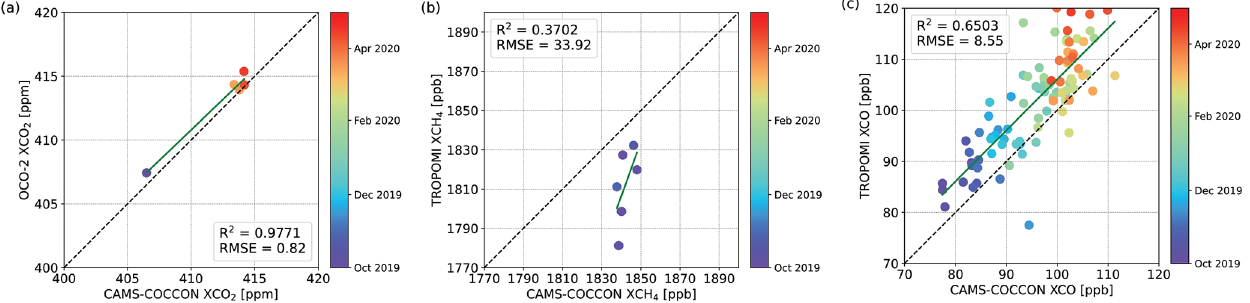
Figure 19. Correlation plots of (a) XCO 2 between OCO-2 and CAMS-COCCON, (b) XCH 4 between TROPOMI and CAMS-COCCON, and (c) XCO between TROPOMI and CAMS-COCCON observations at Yekaterinburg. All satellite data were adjusted for the CAMS a priori profile.